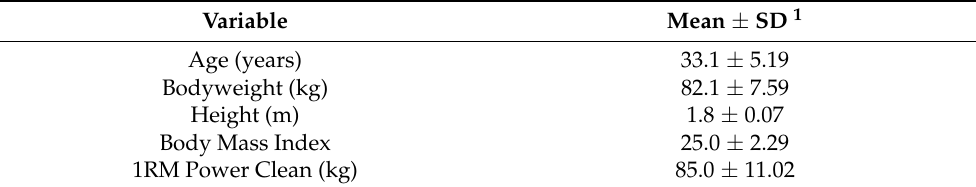
Table 1. Description of participant characteristics ( n = 10, males).